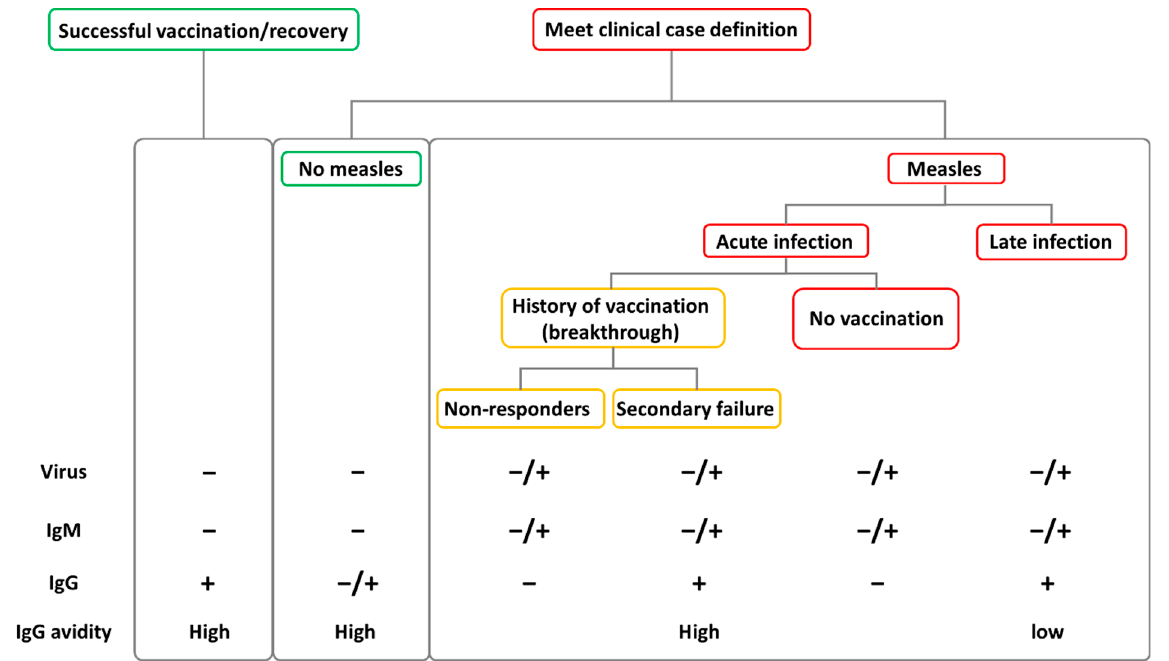
Figure 3. Graphical representation of molecular and serological profiles that can be detected during diagnostic tests in different cases after MV infection compared to non-infected subjects. A primary infection usually causes the development of both IgM, which disappear in later stages of the infection, and long-lasting IgG. When a case meets the clinical definition of measles the presence of IgM and/or the detection of the virus indicates the occurrence of an active acute infection (right panel), while their absence implies a different infection causing the symptoms (middle panel). During an acute infection, a non-immunized subject will not yet present measurable IgG while, in a post-acute infection (beyond 10 days), low-avidity IgG (indicating a recent infection) will be measurable in these subjects (while IgM and virus levels drop) (red boxes in the right panel). During reinfection, IgG would not be measurable in non-responders while high-avidity IgG (indicating a past infection) can be detected in secondary vaccination failure (yellow boxes in the right panel). During a post-acute reinfection non-responders can present low-avidity IgG. A recovered or successfully vaccinated individual will present no acute infection markers (IgM and virus) while possessing high-avidity IgG (left panel).